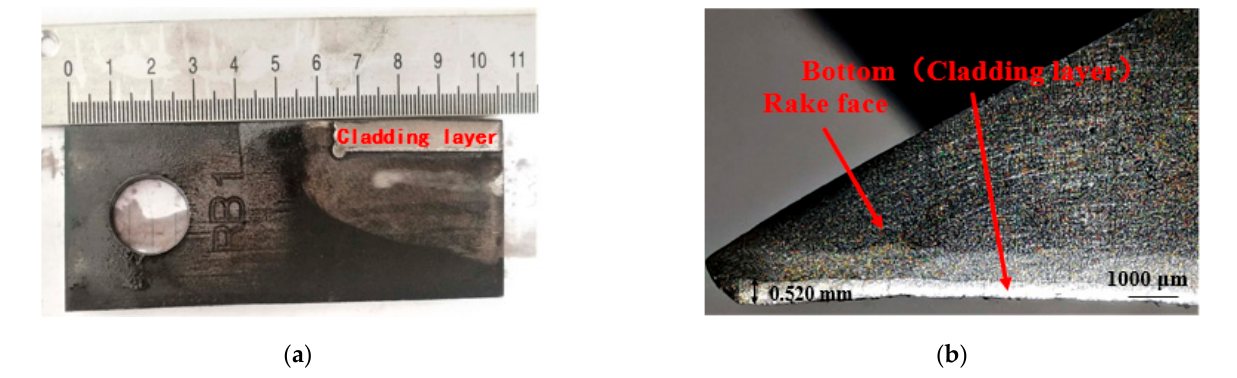
Figure 1. ( a ) Macro-morphology of the silage knife after cladding; ( b ) cross-section morphology of the knife’s edge after cladding. Table 1. Chemical composition of the knife and nickel alloy.